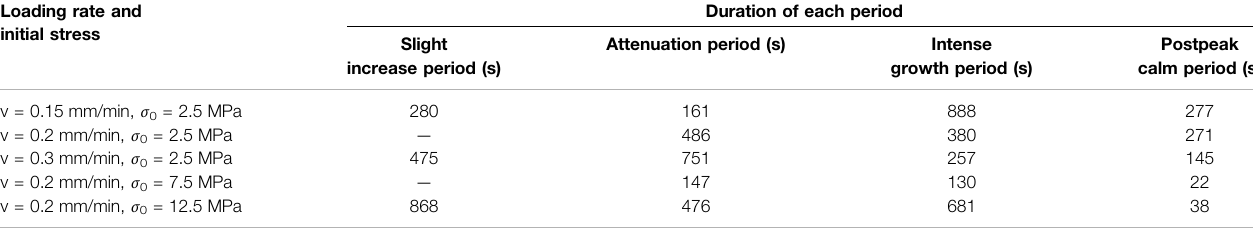
TABLE 3 | Duration of each period of ringing count evolution. Loading rate and initial stress